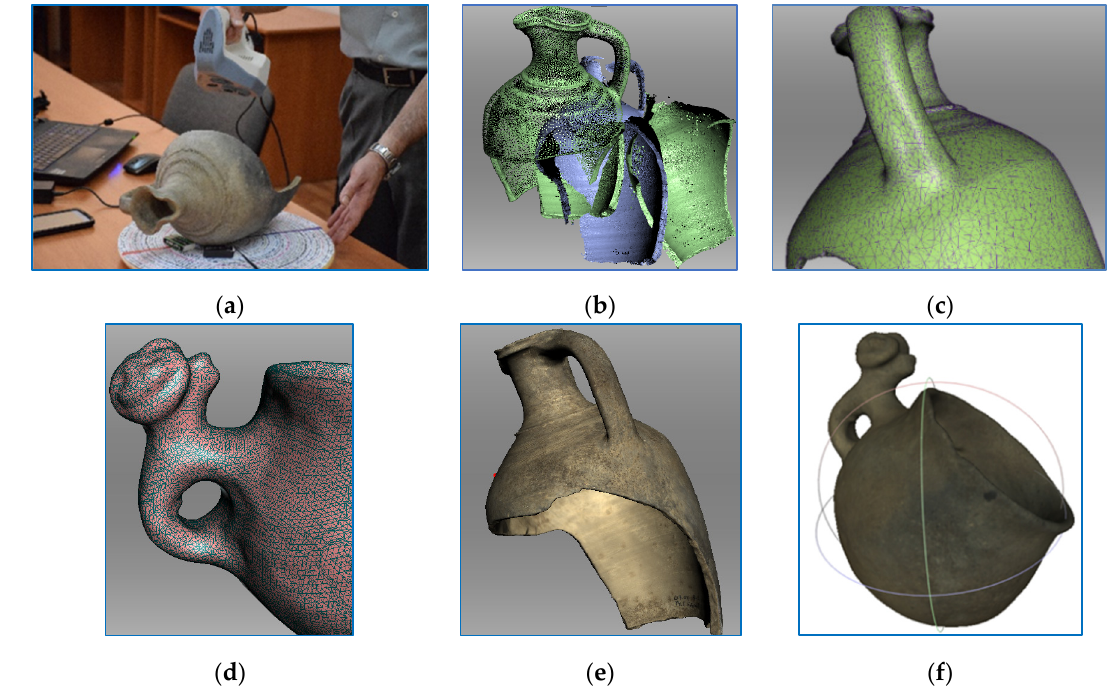
Figure 4. View of: ( a ) the scanning process; ( b ) data processing from the scanning; ( c , d ) the 3D mesh